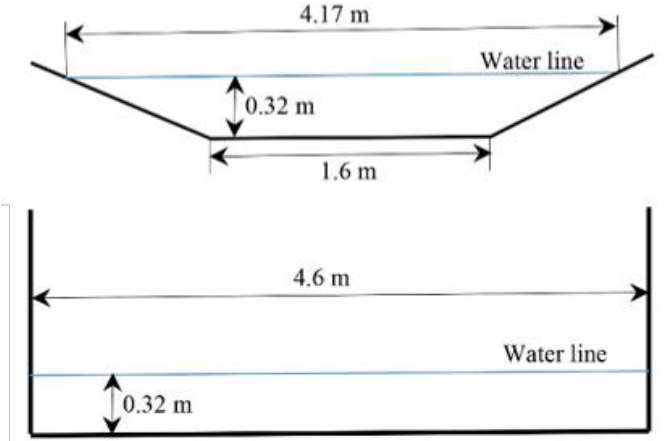
Figure 2. Graphical depiction of the cross-section of the selected case studies. Top: New Suez Canal; bottom: rectangular canal.